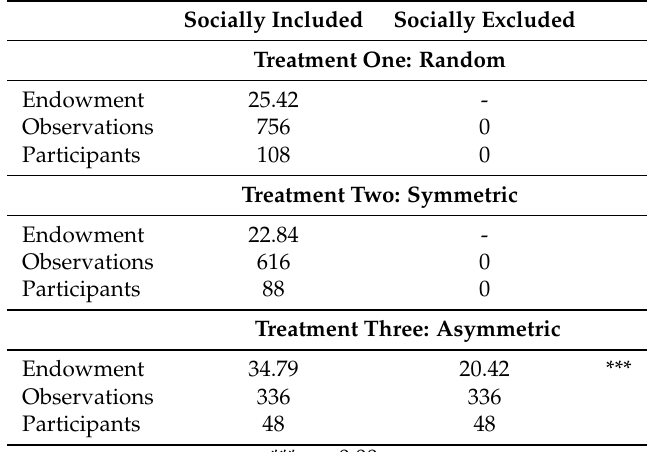
Table 5. Distribution and Endowments of Socially Excluded by Treatment. Socially Included Socially Excluded Treatment One: